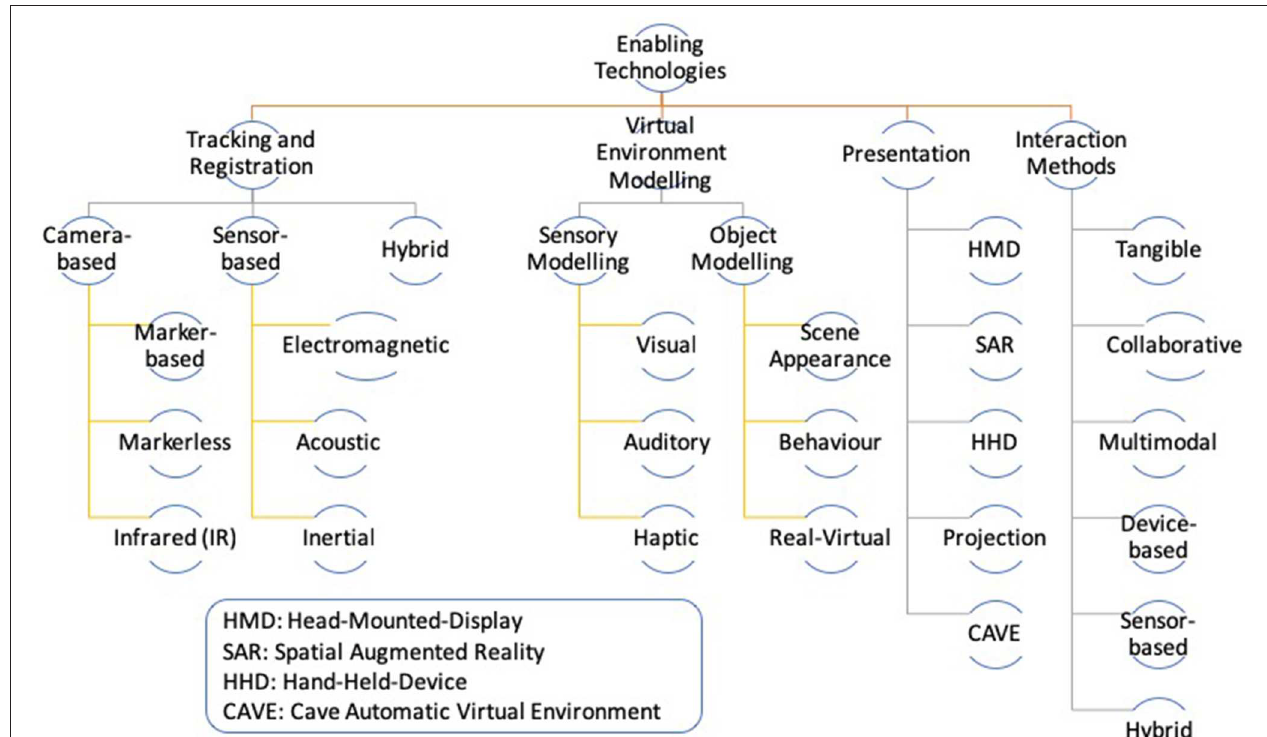
FIGURE 1 | Enabling technologies of immersive reality, summarized from Bekele et al.